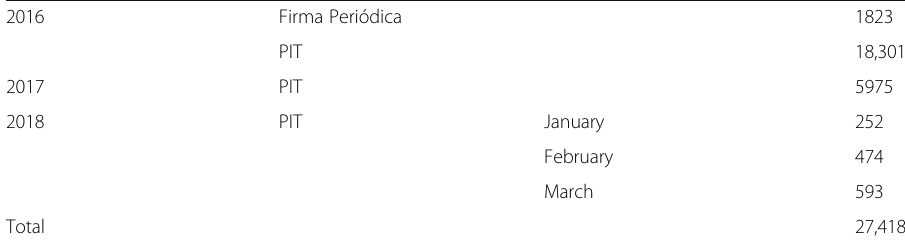
Table 1 Number of registered extra-continental migrants in Costa